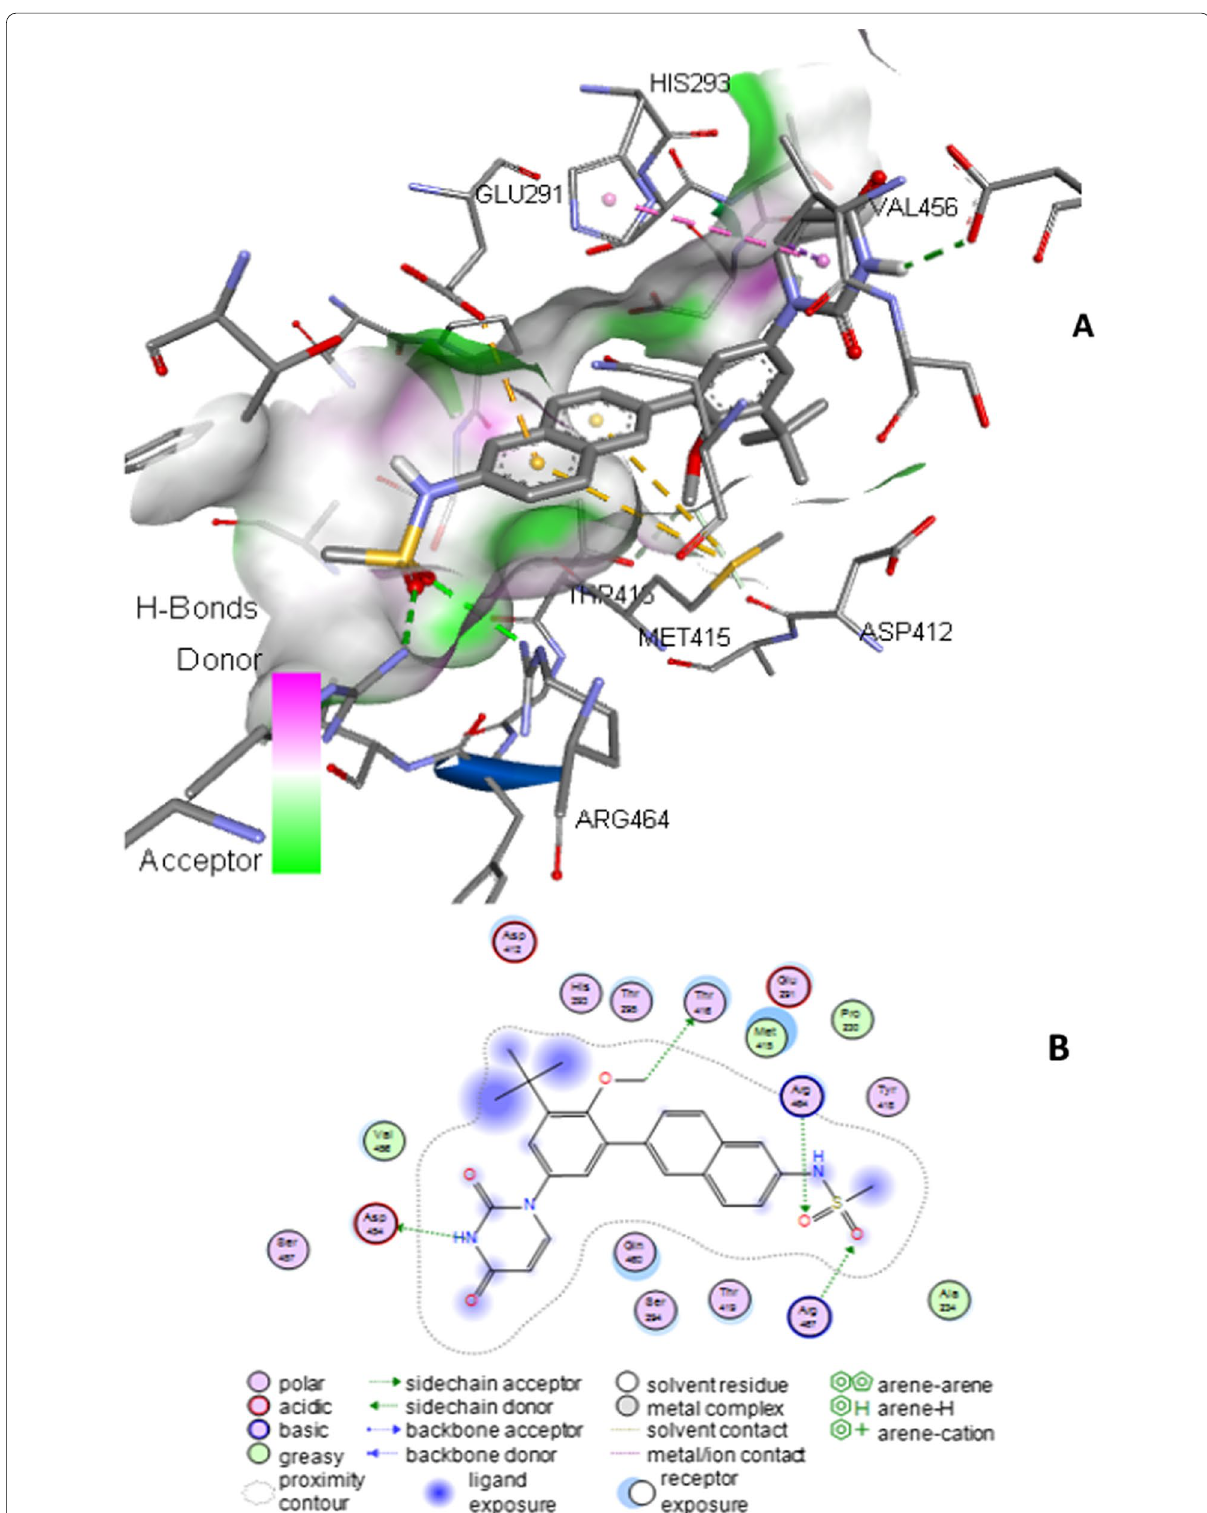
Fig. 6 A 3D diagram for the interaction of reference molecule R (dasabuvir) in complex with the target receptor (hepatitis C virus NS5B RNA polymerase, PDB ID: 4MKA), B 2D diagram for the interaction of reference molecule R (dasabuvir) in complex with the target receptor (hepatitis C virus NS5B RNA